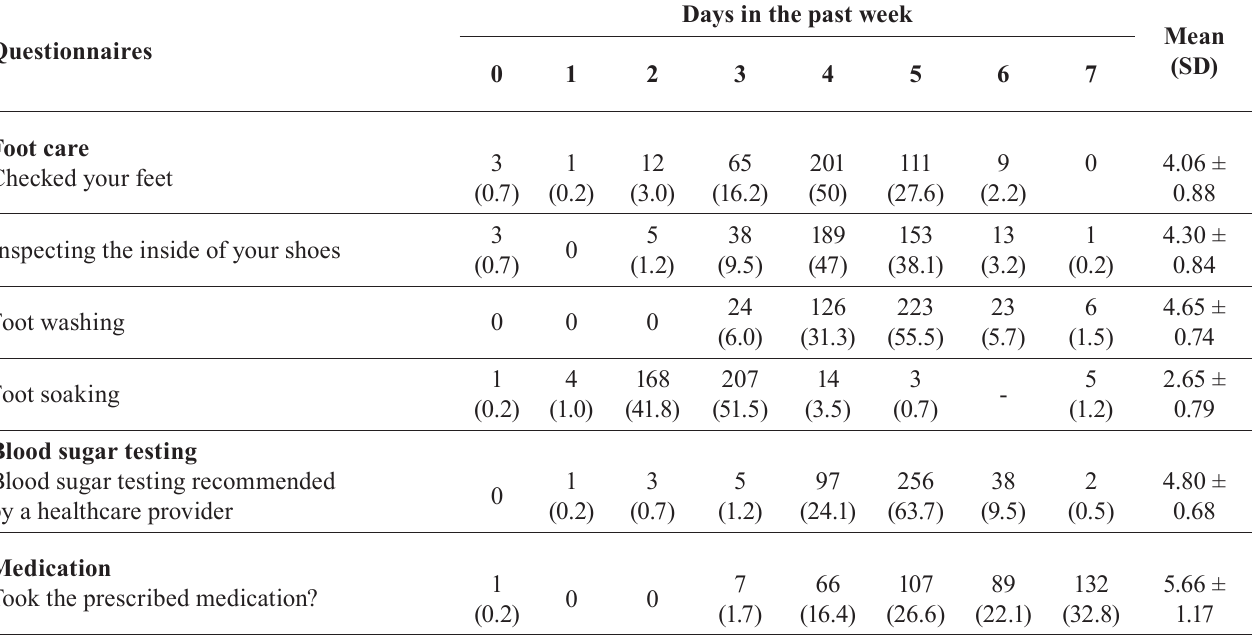
TABLE II - Details regarding the frequencies at which respondents performed diabetes self-care planning activities